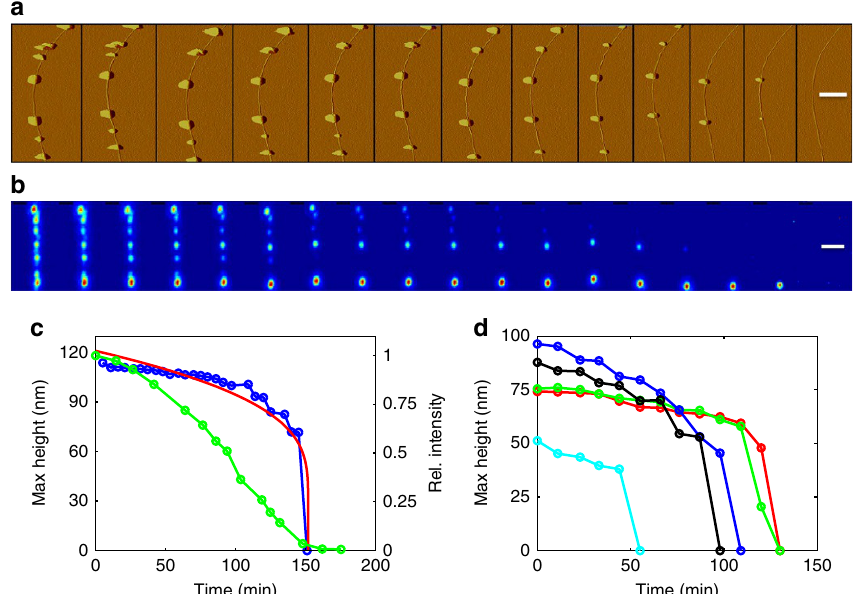
Figure 2 | Sublimation rate of p -nitrobenzoic acid ( p NBA) nanocrystals off carbon nanotubes. ( a ) A temporal set of AFM amplitude images of p NBA nanocrystals (NCs) along a single carbon nanotube (CNT). The time interval between each image is 11min. Scale bar, 1 m m. ( b ) A temporal set of dark field optical microscopy intensity of p NBA NCs along a single CNT. The time interval between each image is 6.5min. Scale bar is 2 m m. ( c ) Left axis: NC height as function of time (blue circles) and theoretical fit according to Supplementary Eq. 7 (red line). Right axis: Relative dark field optical microscopy intensity of p NBA NC along CNTas a function of time (green circles). ( d ) Temporal dependence of the maximum height of different NCs along different p NBA deposition. The zoomed images are presented as insets to Fig. 3a,c and are marked with 1 and 2 according to Fig. 3b. The cross sections of these images were taken along the dotted black lines and are depicted in Fig. 3d. At the top part of Fig. 3d, the cross sections of area 1 (left, blue) and area 2 (right, red) immediately after deposition are plotted. It is evident that the height of these two NCs is above 150 nm. At the bottom of Fig. 3d, the cross sections of area 1 \ 2 (left \ right) before (blue) and sufficiently long time after (red) deposition are plotted. The cross sections look similar, and the average height before and after depositions are practically identical ( h CNT ¼ 3.25 ± 0.25 nm).